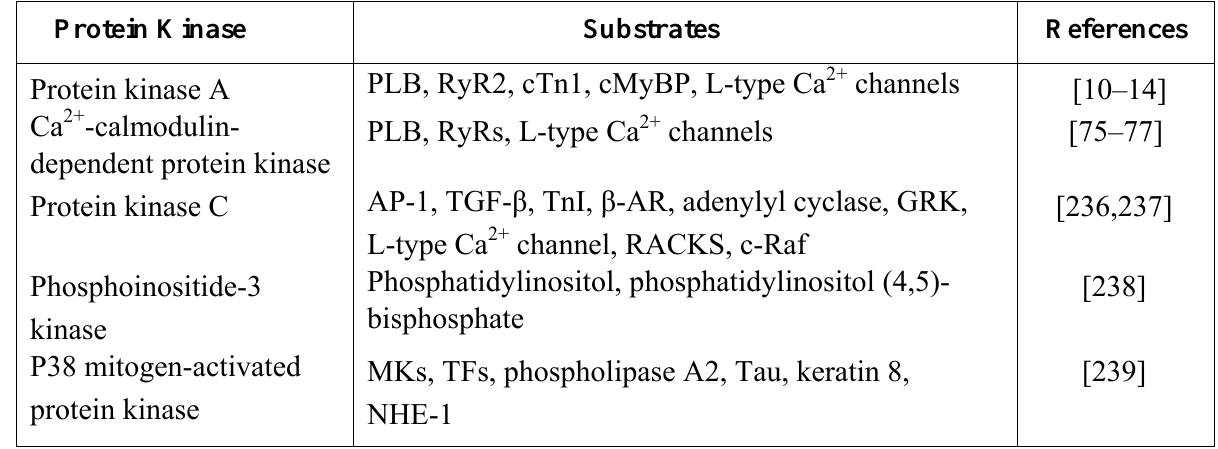
Table 1. Protein kinases and their